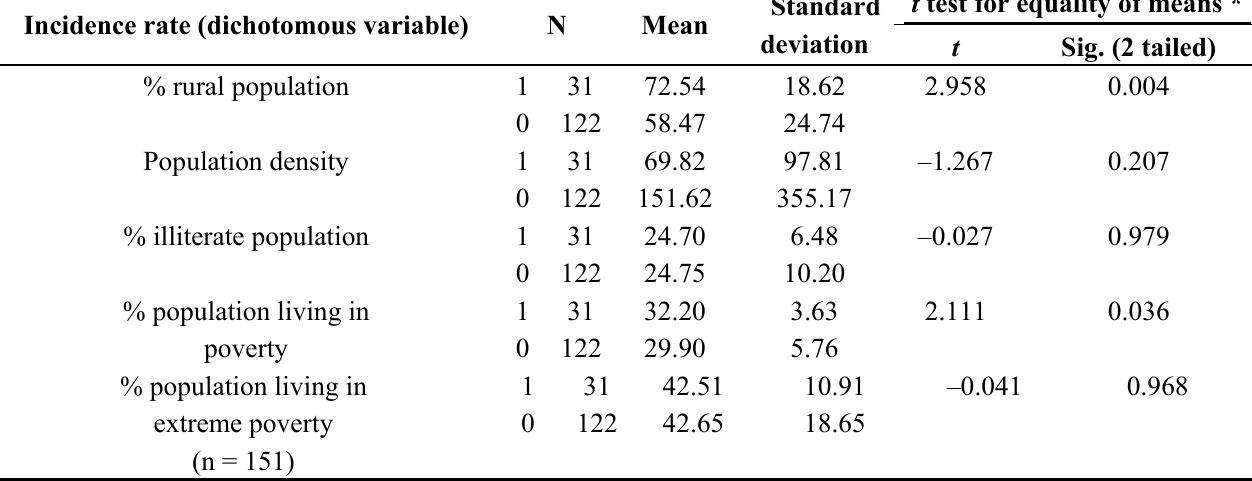
Table 5. Critical (1) and non-critical (0) areas define by incidence rate, number of municipalities, mean, standard deviation, and t test among selected possible drivers,